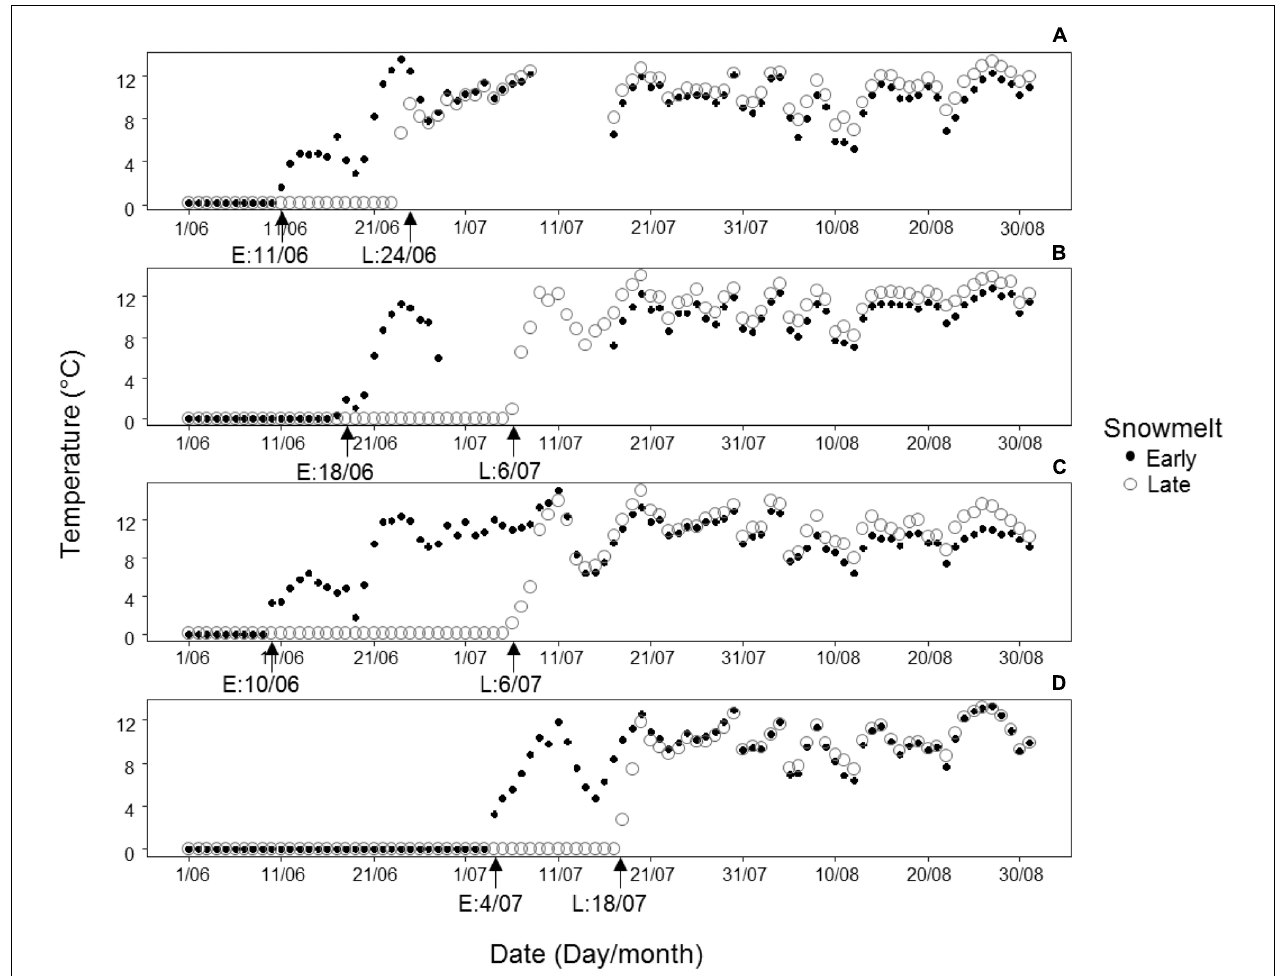
FIGURE 2 | Patterns of daily mean soil temperatures ( ◦ C) registered at 5 cm soil depth during the growing season from melt-out date until the end of August in 2016 in areas of early (E, black points) and late (L, circles) snowmelt at each of the four study sites: (A) Forcella Travenanzes, (B) Pale di San Martino, (C) Val Martello, (D) Passo Gavia. The x axis represents the timescale in intervals of 10 days; the melt-out dates for the areas of early (E) and late (L) snowmelt are indicated by arrows on the x axis. For Forcella Travenanzes data from 8.07 to 16.07 are lacking because of loggers’ malfunction. For the same reason for Pale di San Martino data are lacking from 29.06 to 15.07 for early snowmelt